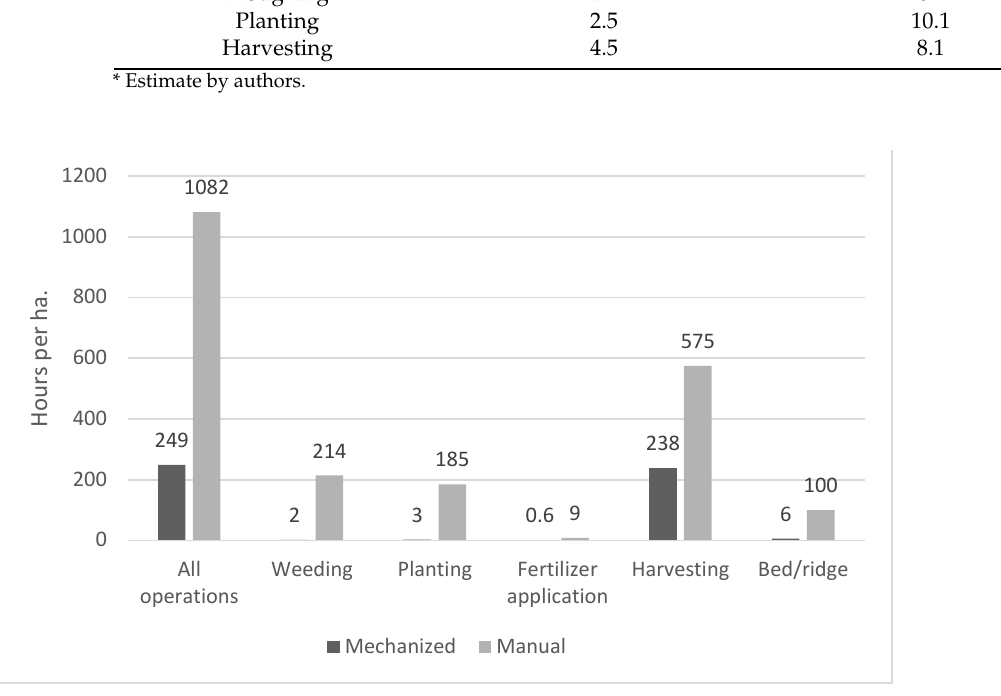
Table 9. Time and Fuel Requirements per ha for Mechanized Processes in Potato Production.